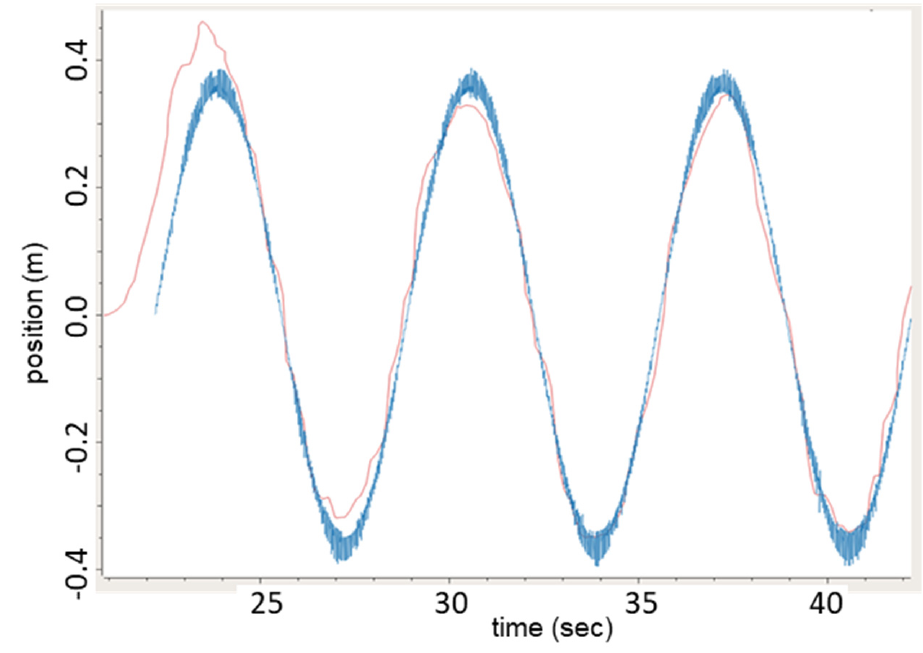
Figure 12. Kalman-based velocity estimation using the SVGS in sinusoidal motion experiments using ground-based linear stage. Orange: SVGS EKF velocity estimate; blue: linear stage true velocity.